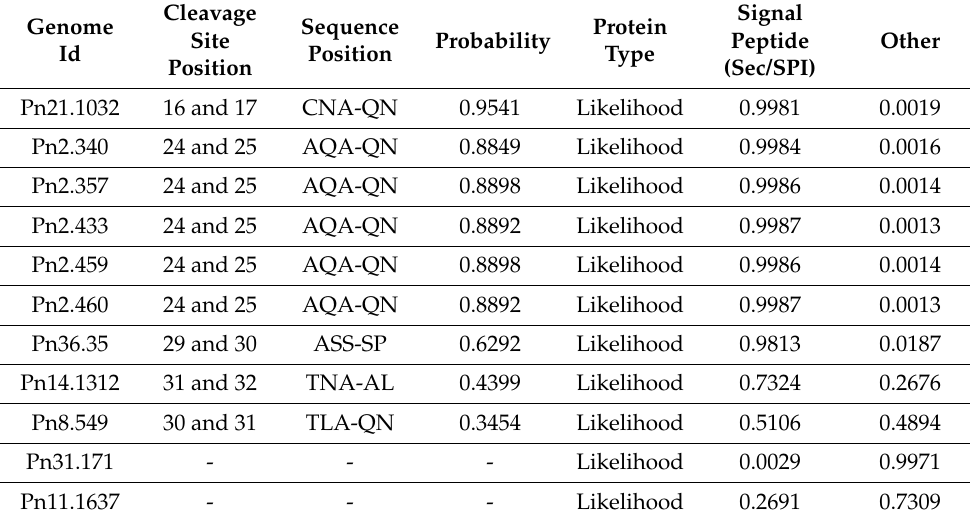
Table 2. Signal peptide region detected from the PnPR-1 proteins.